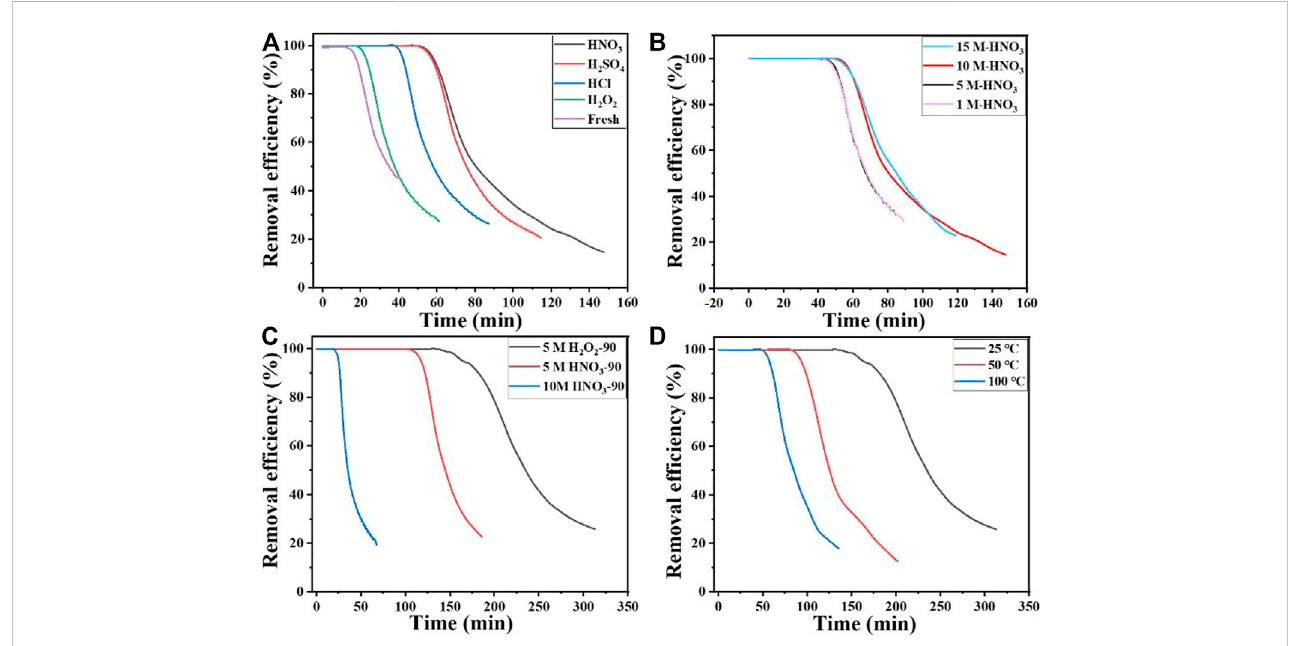
FIGURE 2 Removal ef fi ciency of NH 3 over modi fi ed activated carbon samples under different conditions: (A) modi fi cation by different acids, (B) modi fi cation by HNO 3 of different concentrations, (C) modi fi cation at 90 ° C, and (D) the removal of NH 3 over 10M-HNO 3 -90 at different temperatures.